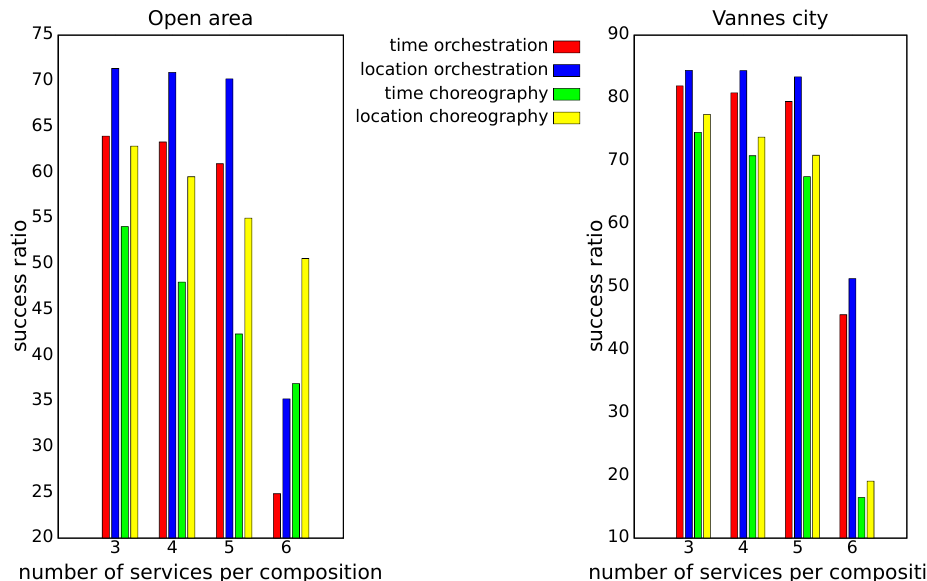
Figure 5. Success ratio against the number of services per